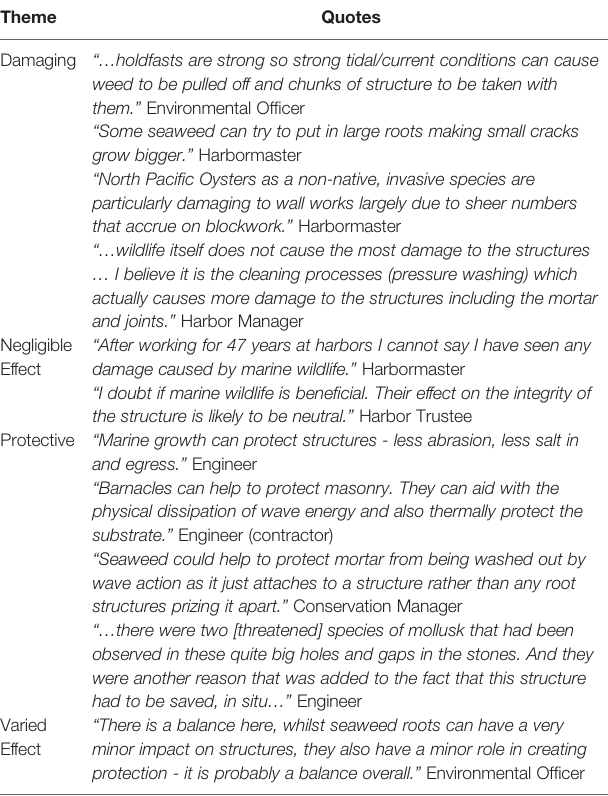
FIGURE 3 | Types of marine wildlife identi fi ed by questionnaire respondents as the most damaging and most protective to historic maritime structures. TABLE 4 | Illustrative quotes concerning the perceived impact of marine growth on the condition of historic maritime